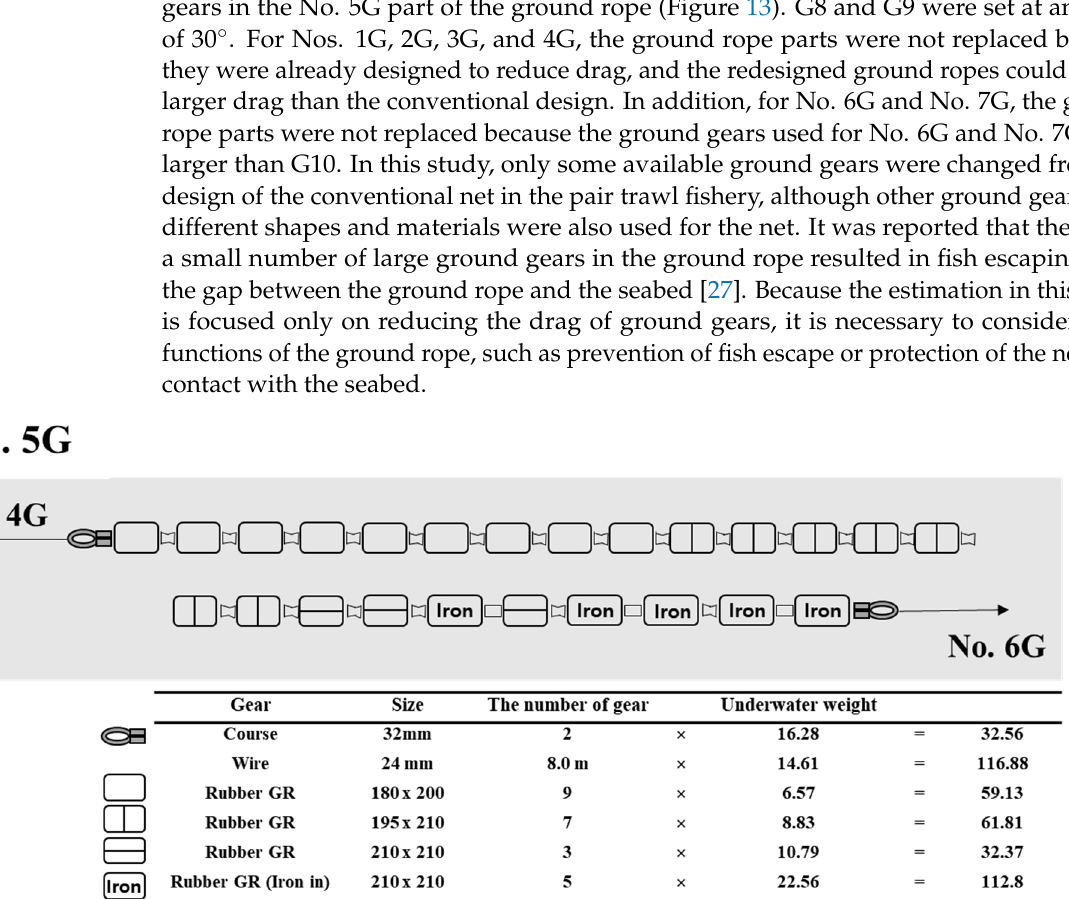
Table 2. The reduction of drag by redesigning floats in each part of the head